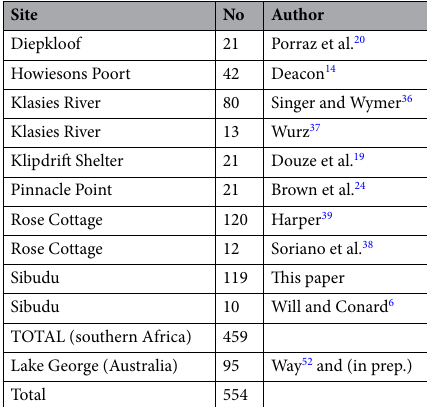
Table 1. The number of backed artifacts in this study by site, showing author and image